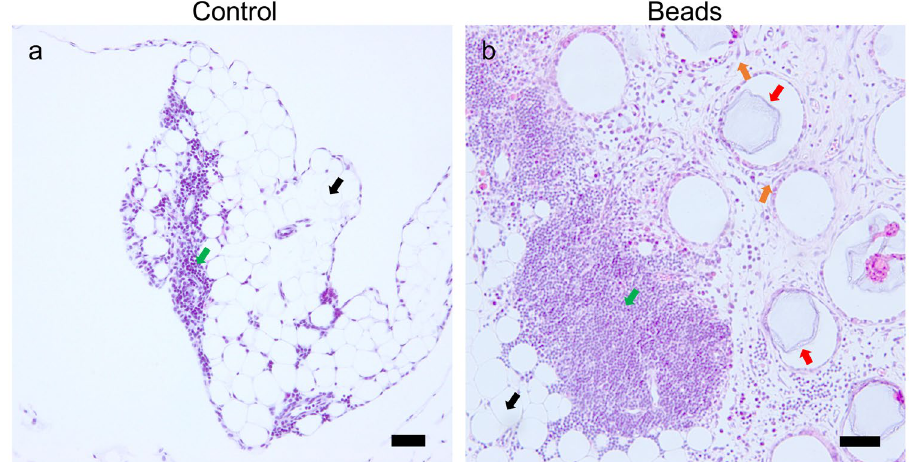
Figure 1. Representative images of the omenta of control and bead-injected mice Immunohistochemistry of the omenta of C57BL/6J mice subjected to H&E staining analysis. ( a) Image of the tissue derived from the control mouse. ( b) Image of the tissue derived from the bead-injected mouse. Bead-based treatment was conducted for a period of 7 days. Black arrows ( a and b ) indicate adipocytes. Red arrows ( b ) indicate polyacrylamide beads. Green arrows ( a and b ) indicate milky spots. Orange arrows ( b ) indicate fibroblasts. Scale bars = 50